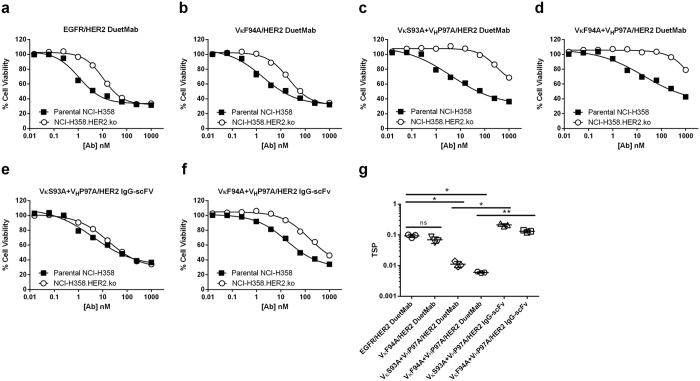
Selective cell cytotoxicity of EGFR affinity-modulated bsAb variants in a cell mixture containing target and non-target cells.(a) Selective cytotoxic activity of parental EGFR/HER2 DuetMab. (b) Selective cytotoxic activity of VκF94A/HER2 DuetMab variant. (c) Selective cytotoxic activity of VκS93A + VHP97A/HER2 DuetMab variant. (d) Selective cytotoxic activity of VκF94A + VHP97A/HER2 DuetMab variant. (e) Selective cytotoxic activity of VκS93A + VHP97A/HER2 IgG-scFv variant. (f) Selective cytotoxic activity of VκF94A + VHP97A/HER2 IgG-scFv variant. (g) Mean of TSP values based upon data from three independent experiments. To determine selective cell targeting and elimination, the double-positive NCI-H358 cells and single-positive NCI-H358.HER2.ko cells were pre-stained with different tracer dyes, combined at equal ratios and incubated with serial dilutions of the various bsAbs. Selective cytotoxic activity was determined by cell imaging cytometry. Each point on the graphs represents the mean values of triplicate wells and the ± standard error of the mean (SEM) is represented by error bars. Statistical significance was determined by One way ANOVA for multiple comparisons (P < 0.05 *P < 0.01 **P < 0.001 ***P < 0.0001 ****ns: not significant).